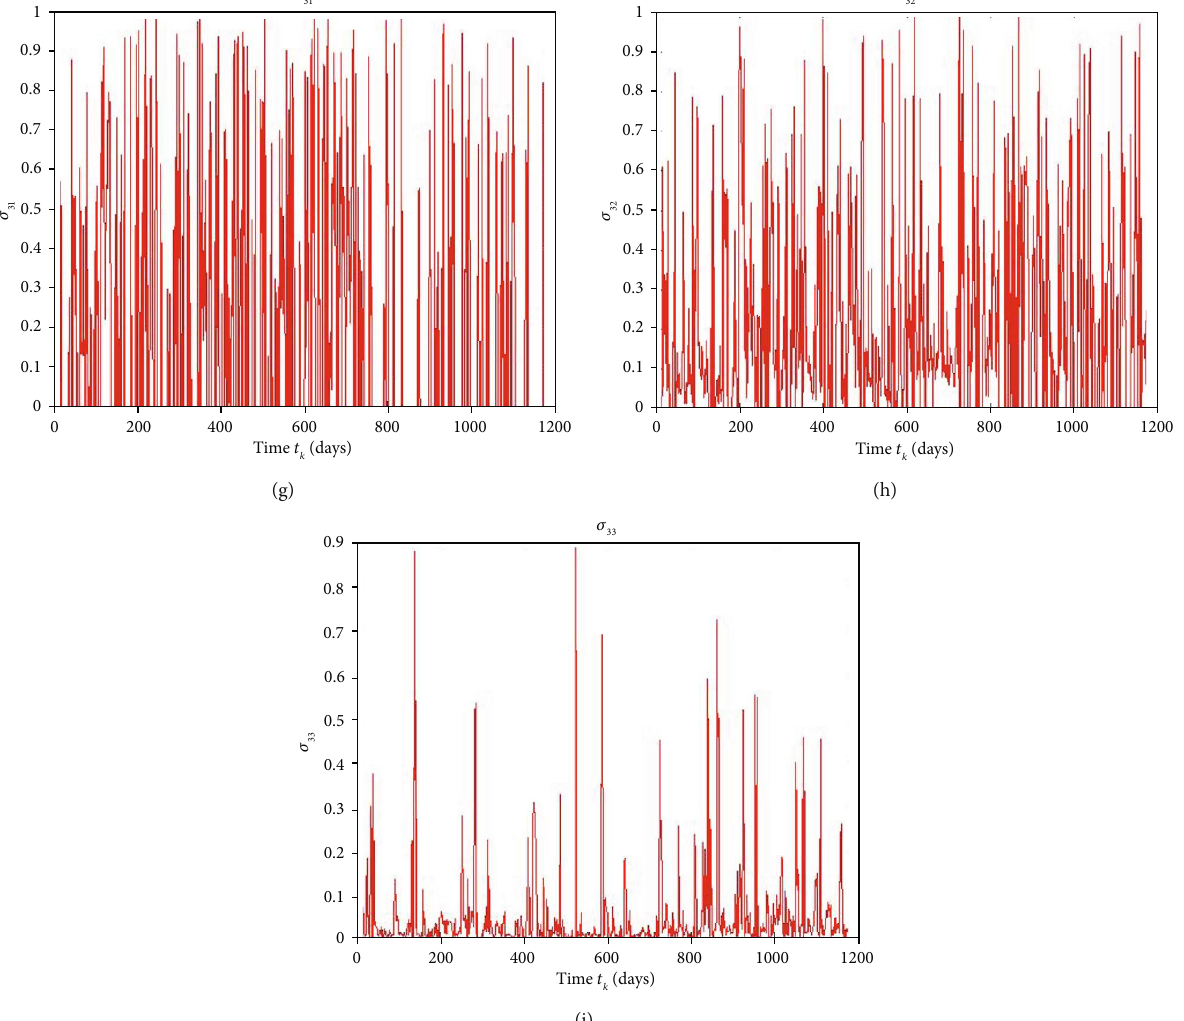
Figure 13: The graph of σ natural gas, crude oil, and coal,